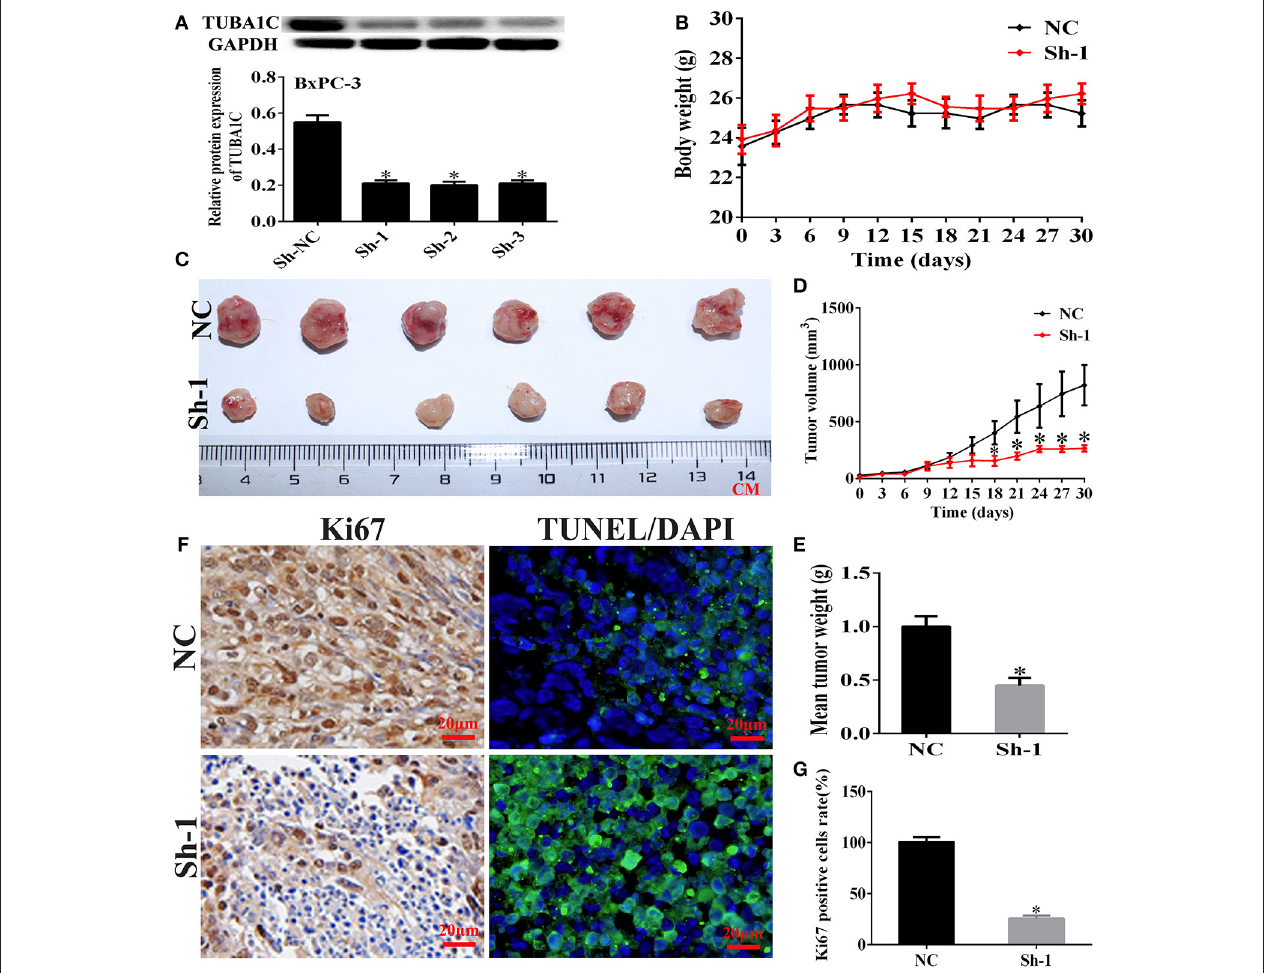
FIGURE 5 | Knockdown of TUBA1C suppressed tumorigenicity in vivo. (A) Evaluation of TUBA1C knockdown in BxPC-3 cell lines after transfection with TUBA1C shRNA by western blotting. (B) Body weight of mice in each group. (C–E) Representative effect of TUBA1C knockdown on tumor growth (tumor volume and weight) ( n = 6). (F) Representative staining images for Ki-67 stained (brown) and TUNEL positive cells (green) counterstained with DAPI (blue) in different groups. (G) Percentage of Ki-67-positive cells in different groups (magnification × 400). ImageJ software was used to calculate the Ki-67-positive cells ( n = 3). The results from the xenograft tumor model are presented as the mean ± SD (* P < 0.05) compared with the negative control (NC)